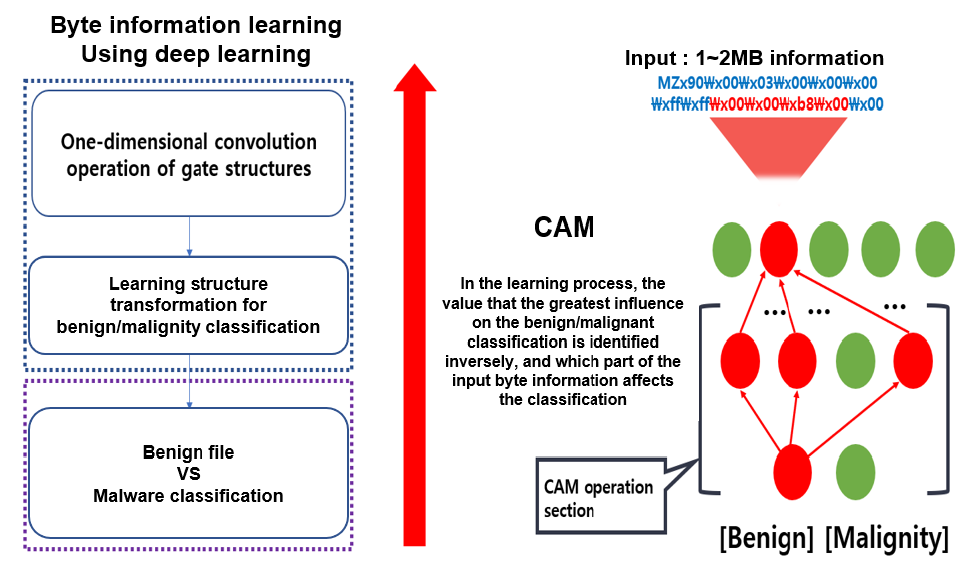
Figure 8. Searching for byte part with the greatest impact on malicious code classification using the class activation map (CAM) method.